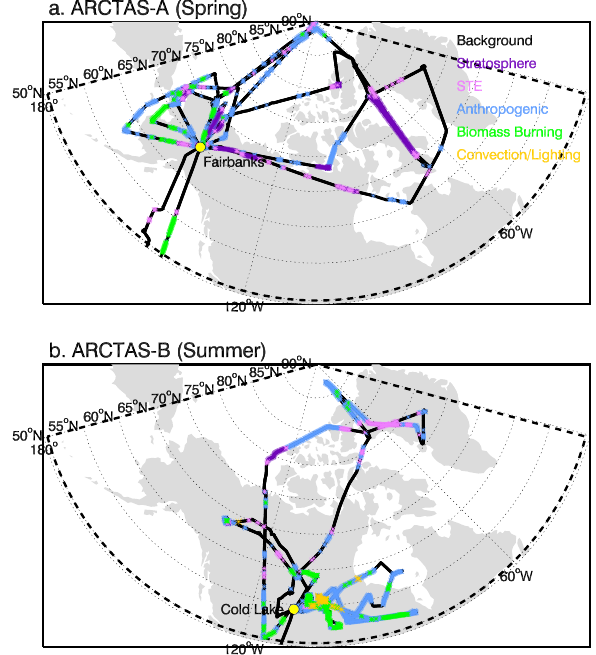
Fig. 1. Flight tracks (black solid lines) of the NASA DC-8 aircraft for (a) ARCTAS-A and (b) ARCTAS-B. For this study, we only use measurements obtained north of 50 ◦ N. The color symbols indicate the location of various air masses sampled during ARCTAS. Tracks not marked with color symbols indicate background